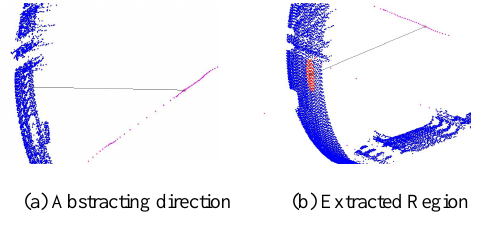
Fig.3 Quadric fitting of the vicinity of